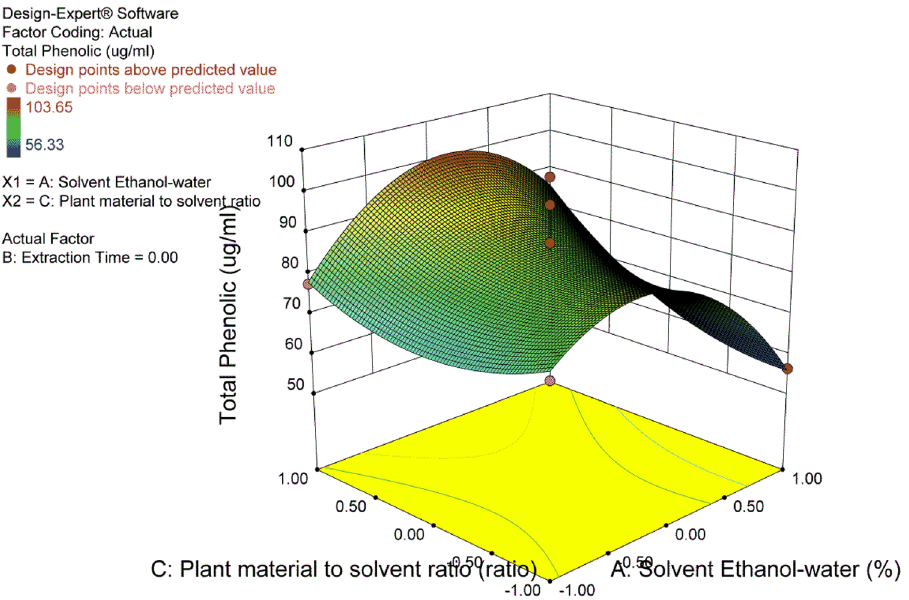
Figure 3. 3D response surface plot for the total phenolic content (Y 2 ). Effect of A (ethanol/water ratio), C (material/solvent ratio) and their interaction on the total phenolic